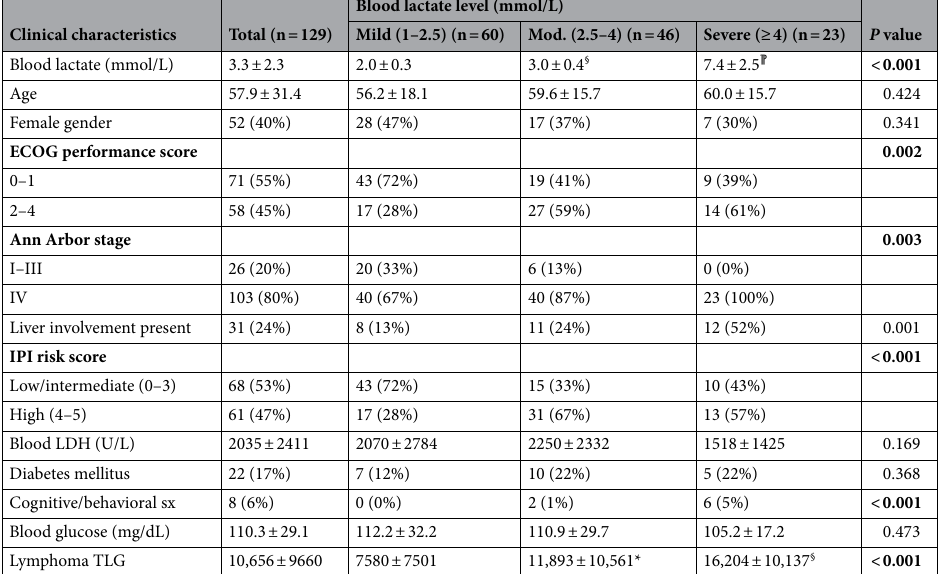
Table 1. Clinical characteristics of total population and according to blood lactate level. Significant values are in bold. Mod, moderate; ECOG , Eastern Cooperative Oncology Group; FDG, 18 F-fluorodeoxyglucose; SUVave, average standard uptake value; IPI, International Prognostic Index; LDH, lactate dehydrogenase; sx, symptom; TLG, total lesion glycolysis. Data are represented as means ± standard deviations. ⁋ P < 0.001 compared to all other groups; § P < 0.001 compared to the mild group; * P < 0.05 compared to the mild